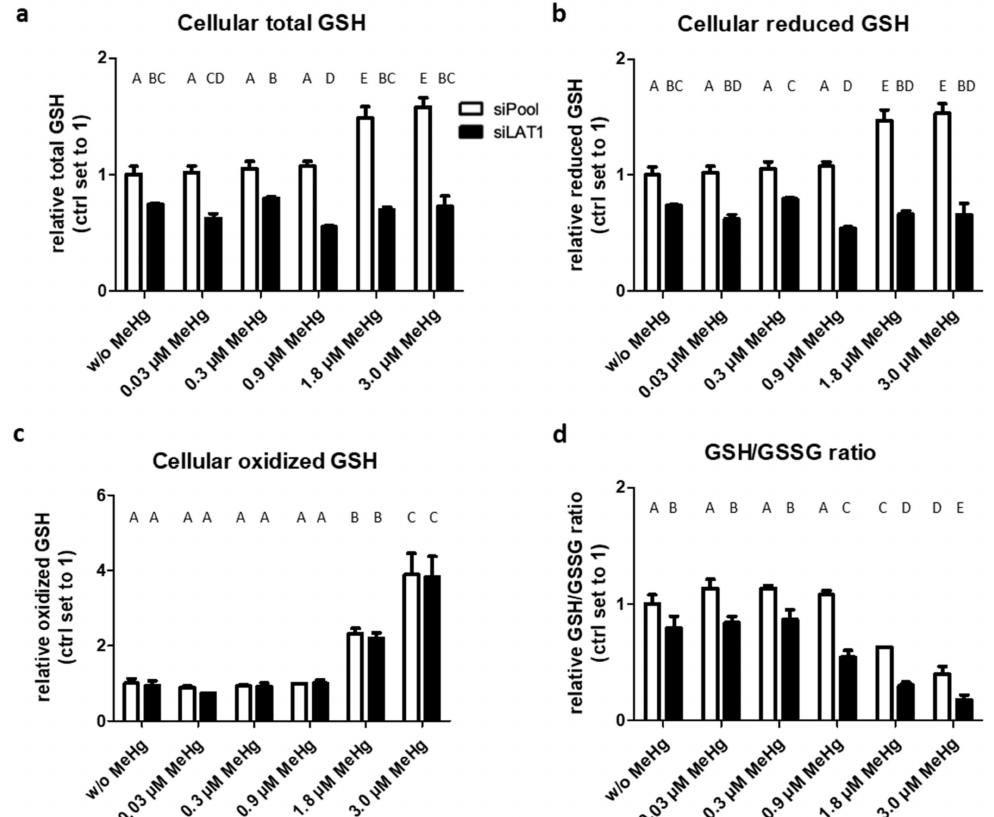
Figure 4. Effects of MeHg treatment and LAT1 downregulation on GSH status in HTR-8/SVneo cells. Exposure to MeHg led to dose-dependent increases in total glutathione (GSH) ( a ), reduced GSH ( b ), and oxidized GSH (GSSG) ( c ) and decreased the GSH/GSSG ratio ( d ) relative to controls (w/o MeHg). The LAT1 knockdown (siLAT1) reduced GSH levels, and thereby the GSH/GSSG ratio compared to control cells (siPool). The data represent mean values ± SD from three independent experiments, each performed in triplicate. Letters A–E denote homogeneous subgroups derived from one-way ANOVA and S–N–K post hoc test ( p <